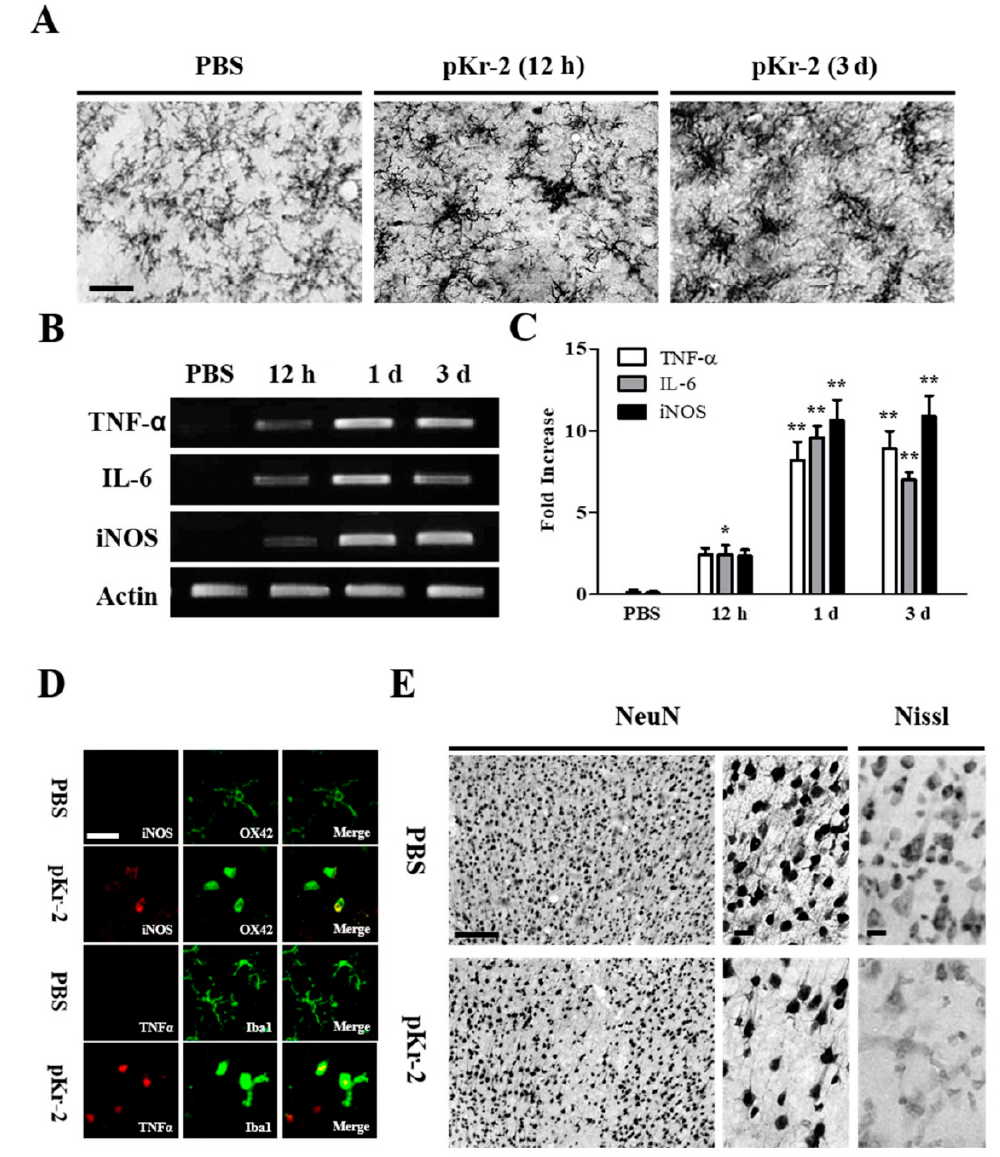
Figure 1. Microglial activation by prothrombin kringle-2 (pKr-2) leads to death of cortical neurons by increasing expression of proinflammatory cytokines in vivo. ( A – C ) pKr-2 (48 µ g / 4 µ L) or PBS as a control was unilaterally injected into the cerebral cortex. Animals were killed at indicated time point, brains tissues were prepared for immunohistochemical staining and Reverse-Transcription Polymerase Chain Reaction (RT-PCR) analysis. For the immunohistochemistry, coronal sections (40 µ m) were cut using sliding microtome. Every sixth serial sections were selected and processed for OX-42 immunostaining for microglia. ( A ) Note morphological changes in OX-42 + microglia from resting (small cell bodies and thin, long, or ramified processes) to activated state (larger cell bodies with short processes). ( B , C ) RT-PCR analysis of anti-tumor necrosis factor- α (TNF- α ), Interleukin-6 (IL-6), and inducible nitric oxide synthase (iNOS) ( B ), and quantification ( C ) in the cerebral cortex of pKr-2-injected rat brain at the indicated time points. Error bars represent the mean ± SEM. * p < 0.05, ** p < 0.001 compared with control according to Student t -Test and One way ANOVA and Newman-Keuls analyses. ( D ) Fluorescence images showing co-localization of iNOS (red) and OX-42 + microglia (green) or TNF- α (red) and Iba1 + microglia (green) in the cerebral cortex at one day after intracortical injection of pKr-2 or PBS as a control. ( E ) Immunohistochemical staining showing loss of NeuN + and Nissl + in the cerebral cortex at three days after intracortical injection of pKr-2 or PBS as a control. Scale bars, A , 150 µ m. D , 20 µ m, E , 25 µ m; A , n = 4 to 6; B , C , n = 4; D , n = 4; E , n = 4 to